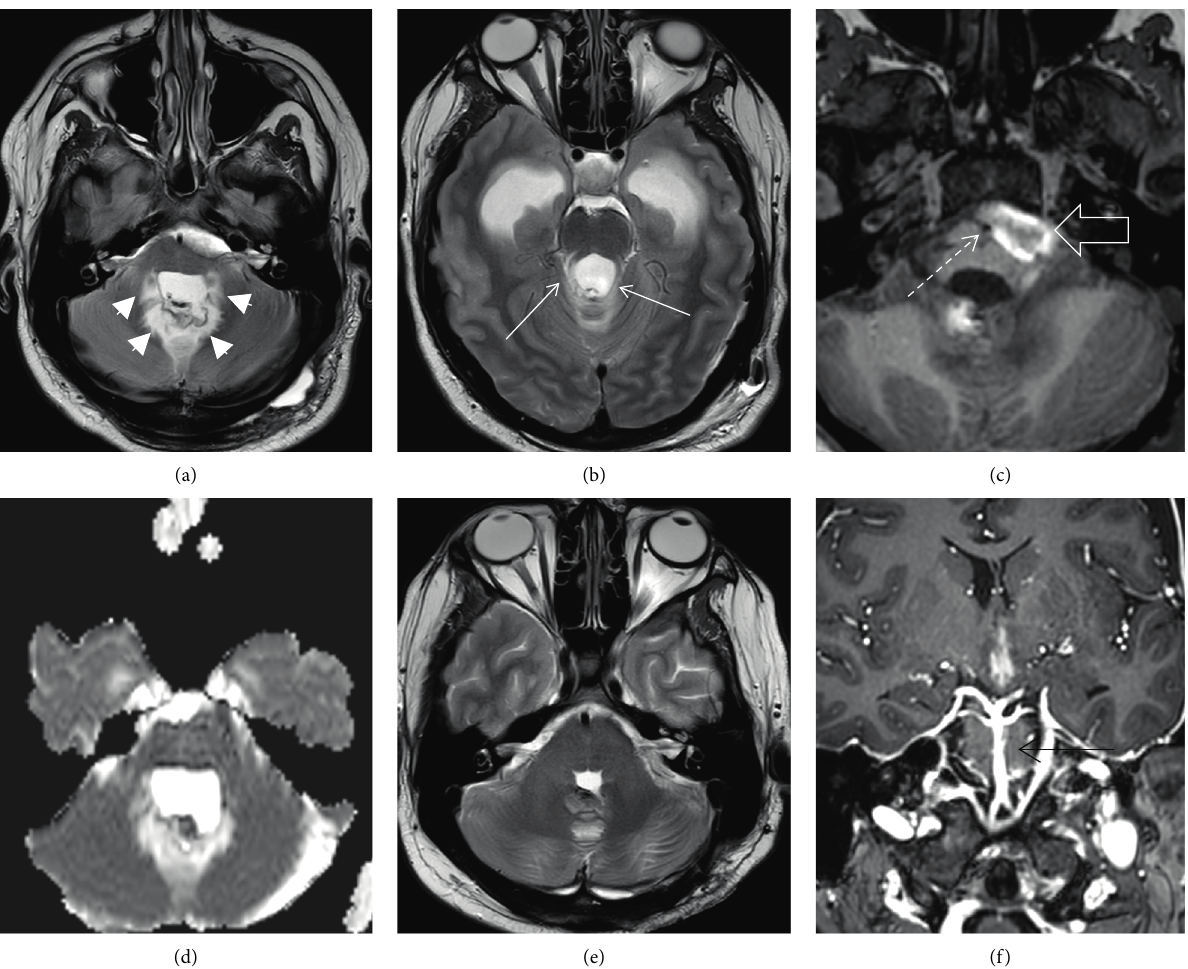
Figure 3: Axial T2 weighted images (a, b) from the MRI performed on day 14 demonstrate bilateral hyperintensity in the regions of the dentate nuclei, middle cerebellar peduncles (white arrow heads), and the superior cerebellar peduncles (white arrows). The T1 weighted image (c) demonstrates the narrow basilar artery (white dashed arrow) and the adjacent haematoma (white open arrow). The ADC image (d) demonstrates unrestricted diffusion in the region of the T2 abnormalities. MRI scan performed 6 weeks following surgery demonstrates complete resolution of the T2 abnormality (e) and normal calibre of the basilar artery (black arrow) on the post-contrast image (f) as compared to the changes seen on Figure